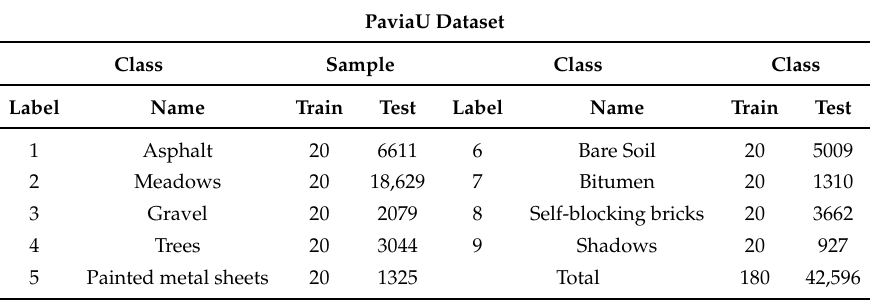
Table 1. Number of training and testing samples in each class for the PaviaU dataset.